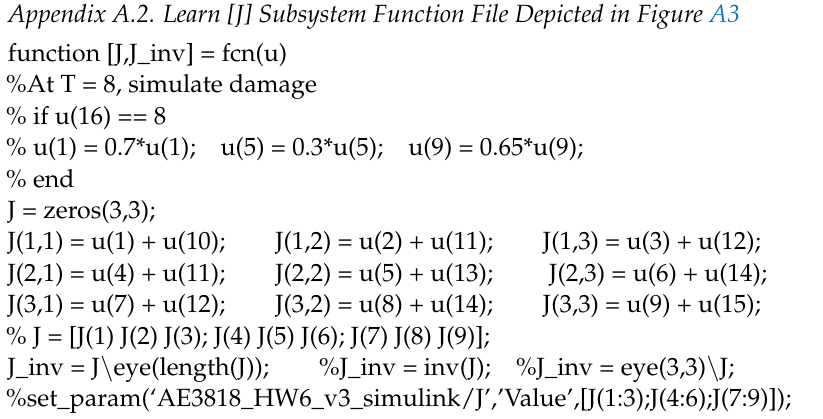
Figure A3. controllers’ and observers’ subsystem depicted in Figure A1.